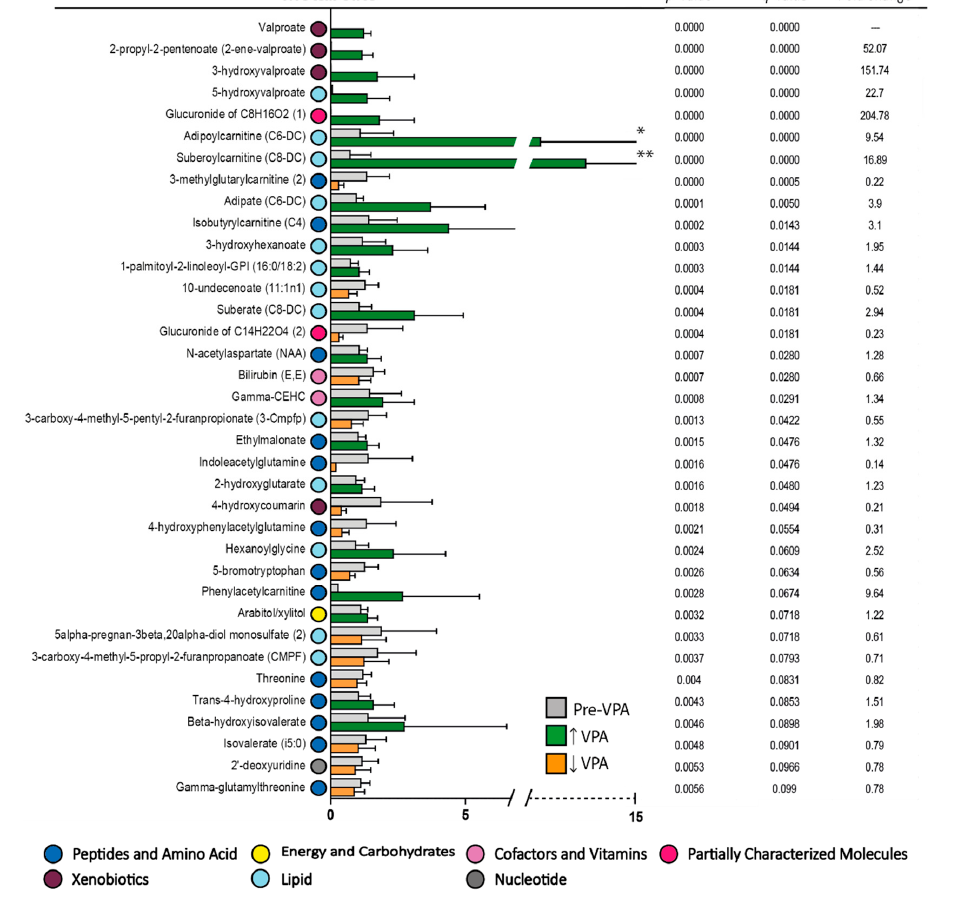
Figure 5. Identification and classification of serum metabolites that differed significantly when comparing samples taken prior to treatment and after seven days of valproic acid (VPA)